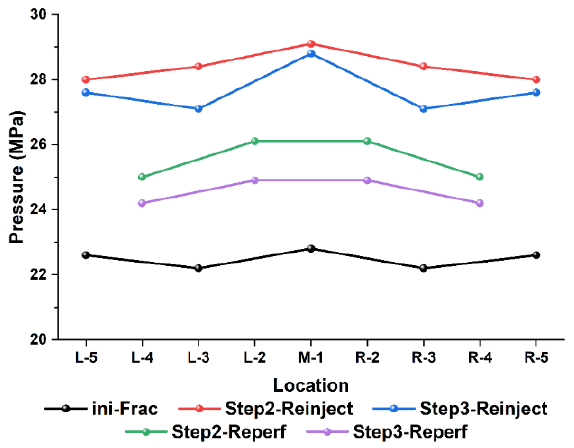
Figure 13. Fracture extension pressure of different fracturing methods.